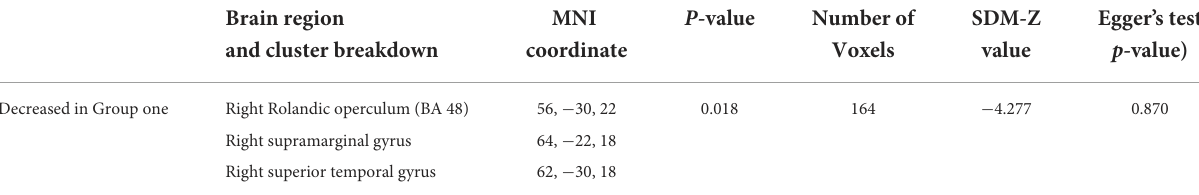
TABLE 5 Clusters of group 1 differences in patients with T2DM compared to healthy